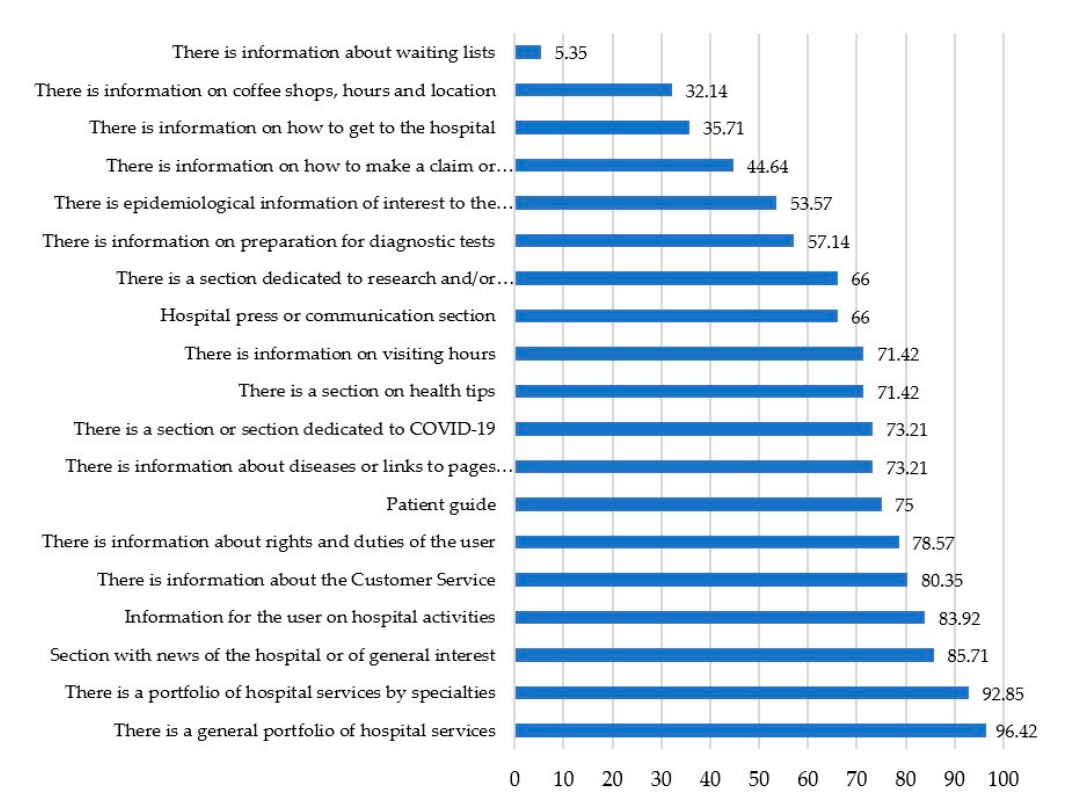
Figure 6. Website information offered. Own elaboration.